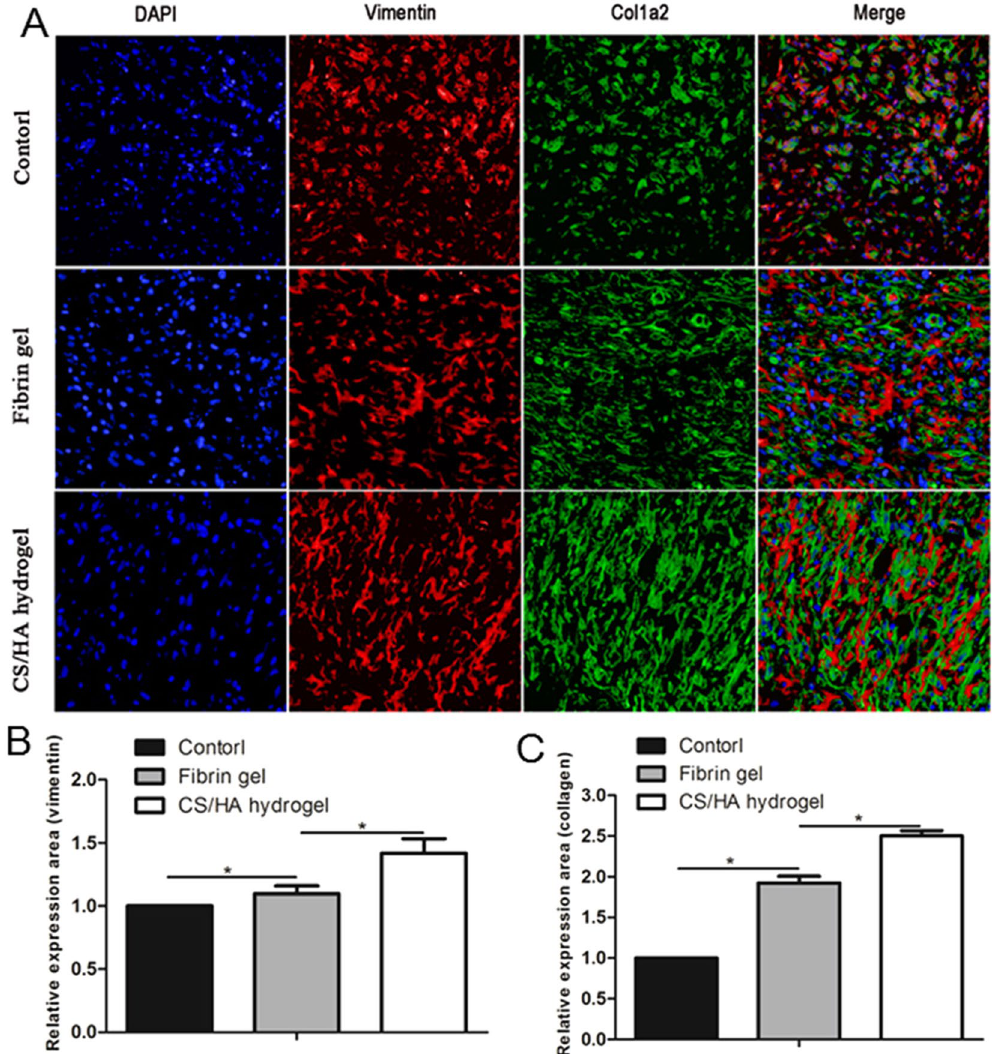
Figure 5. ( A ) Representative immunofluorescent images of collagen deposition in the three groups. DAPI (nuclei) = blue, Vimentin (fibroblasts) = red, Col1 α 2 (collagen) = green. The merge images revealed that collagen expression was found both in and around vimentin-expressing fibroblasts. ( B ) Quantification of vimentin expression. ( C ) Quantification of collagen